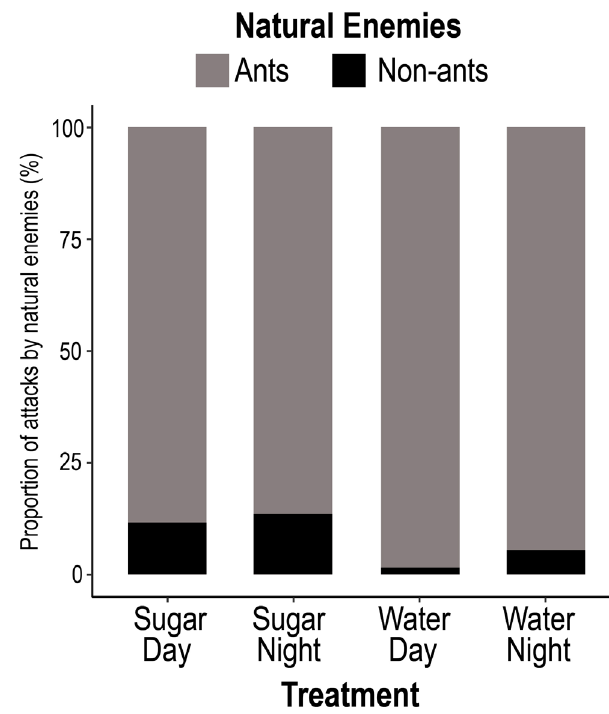
Fig 2. Proportion of attack marks left by ants and other natural enemies on dummy caterpillars near artificial nectaries fixed on the branches of the shrub Prosopis laevigata (Fabaceae) during day and night and with different food source quality treatments over a 48-hour period.